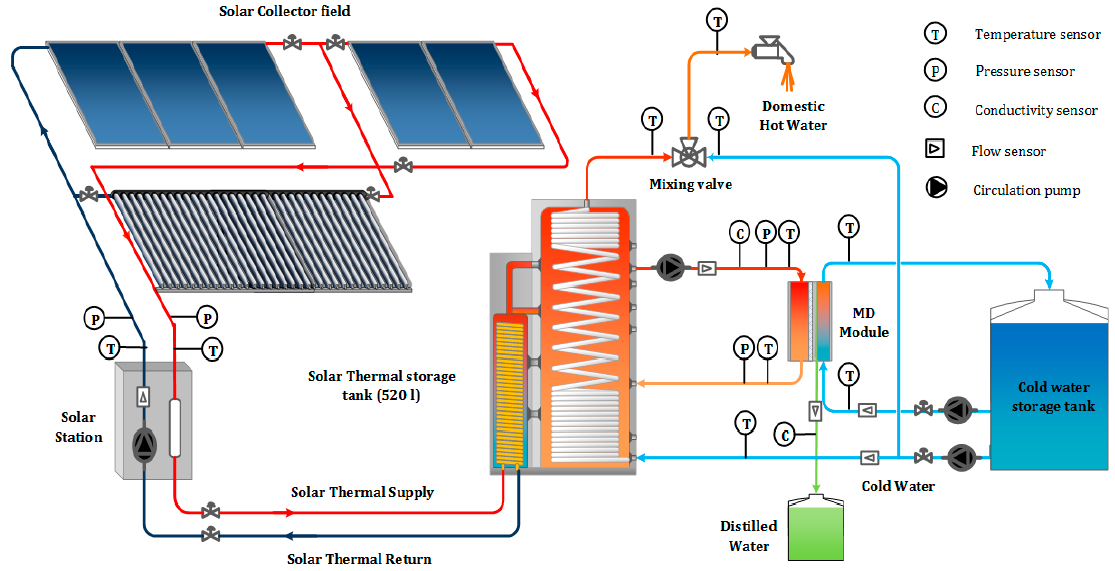
Figure 4. Schematic representation of thermal store integrated MD (STSMD).